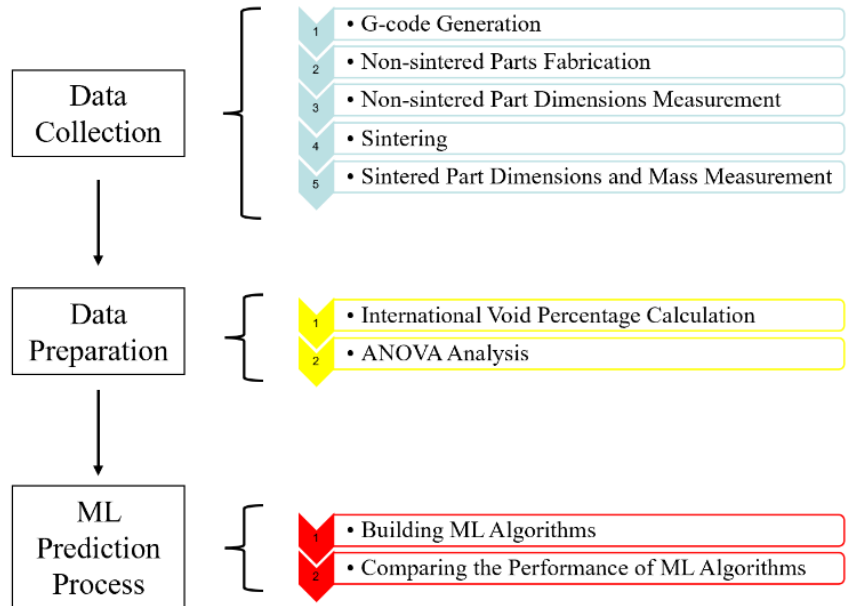
Figure 4. Process workflow of the research .